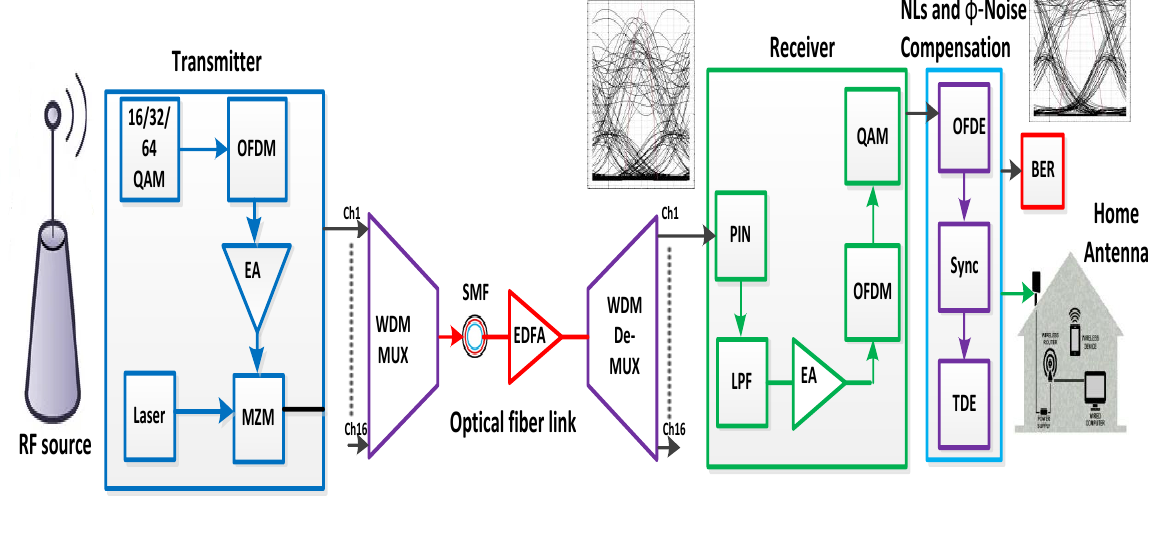
Figure 1. The proposed wavelength division multiplexing (WDM)-based Radio-over-fiber (RoF) model with an advanced digital signal processing (DSP)